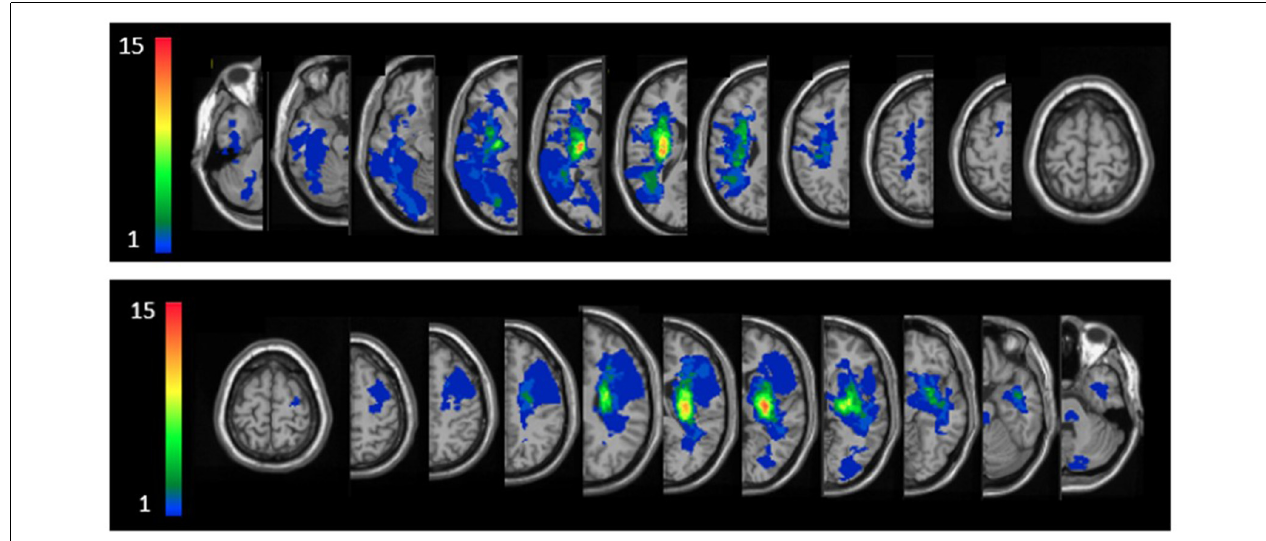
Individual lesion data are displayed in Supplementary Figure S1 . Overlay lesion maps (stroke lesion distribution) of left hemisphere damaged (LHD) and right hemisphere damaged (RHD) patients are presented in Figure 2 . As can be seen, in both groups the maximal lesion overlap was in the capsular-putaminal region. Comparisons between groups for the locations of lesions are presented in Supplementary Tables S1A,B .